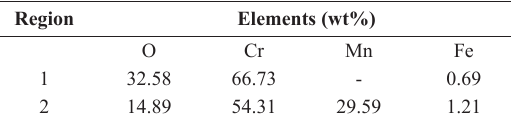
Table 3: EDS analysis results of regions 1 and 2 in Fig.6c